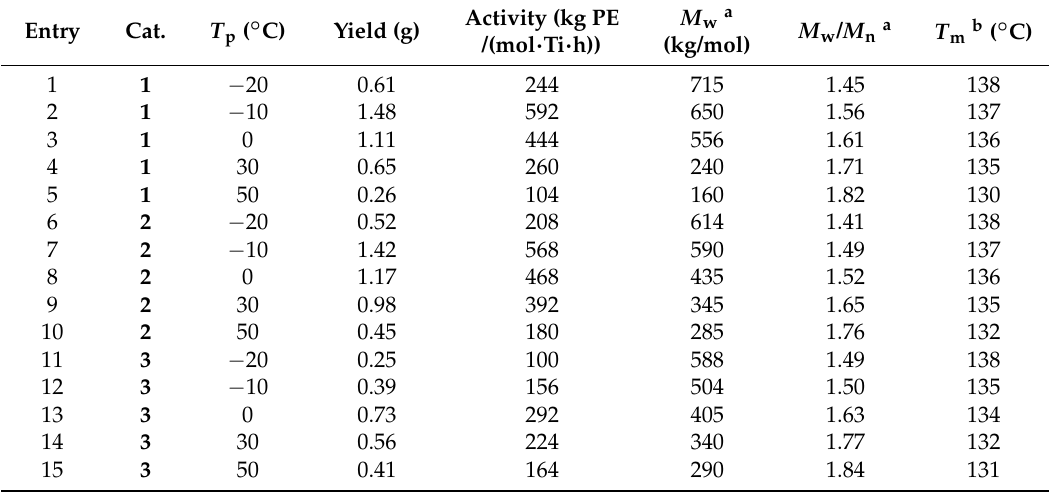
Polymerization conditions: Ti complex, 5 μ mol; Al/Ti = 200; ethylene pressure, 1.5 atm; reaction time, 30 min, solvent, toluene; total volume: 35 mL; a Determined by high temperature gel permeation chromatography (GPC) in 1,2,4-trichlorobenzene at 150 °C; b Determined by differential scanning calorimetry (DSC).